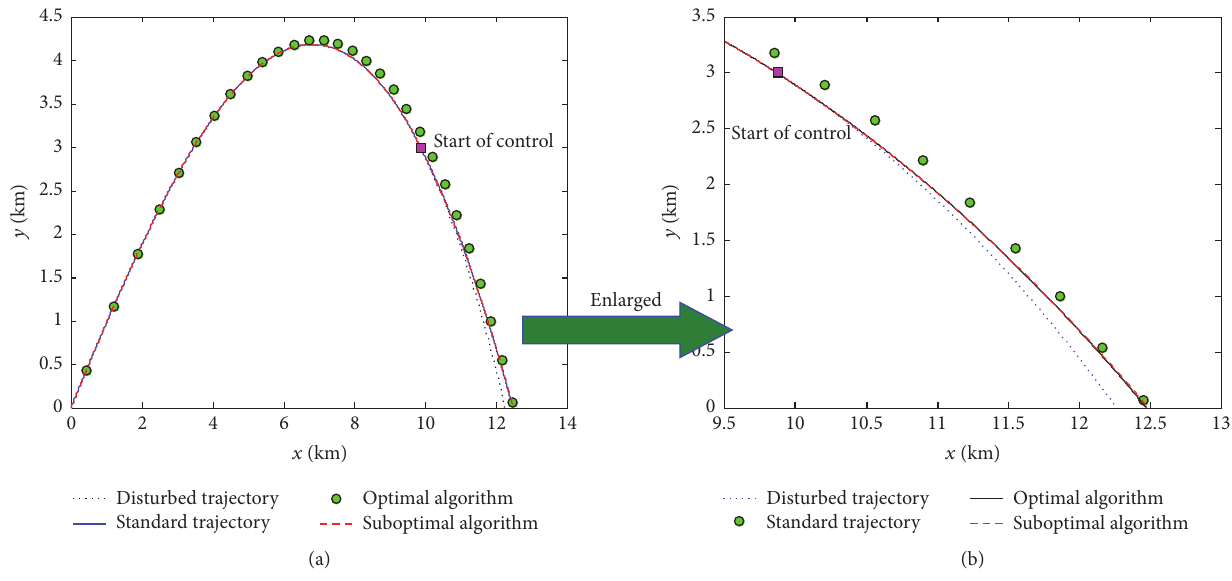
Figure 8: (a) Curve of trajectory under different conditions. (b) Enlarged curve of terminal trajectory.